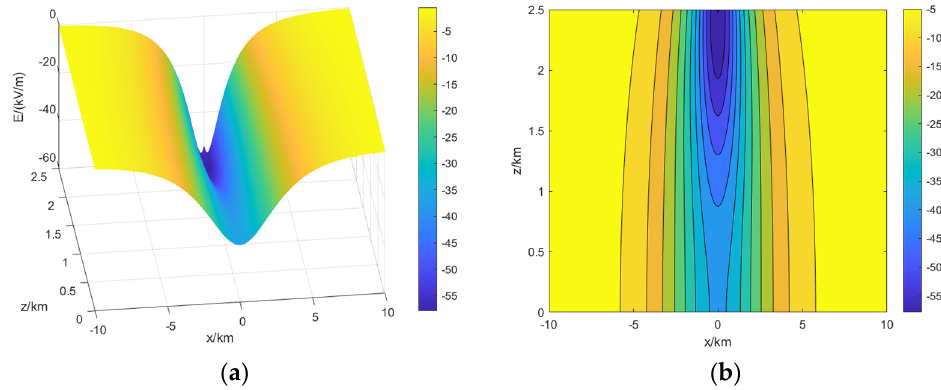
Figure 7. ( a ) Electric field distribution on the longitudinal section while y = 0. ( b ) Contour of potential distribution on the longitudinal section while y = 0.